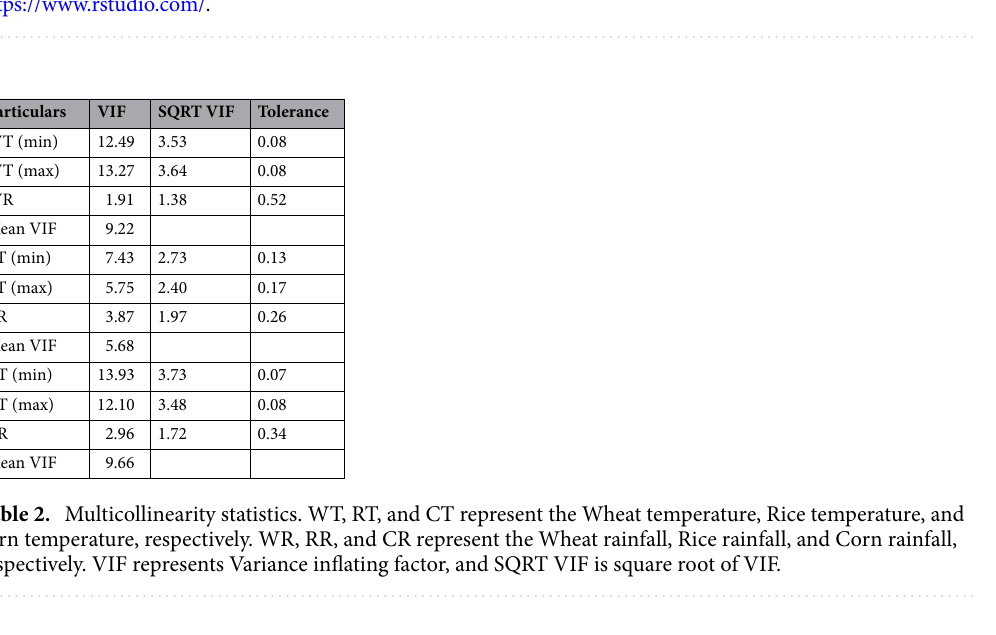
Figure 1. The map showing 11 states of SE-US considered in this study. Figure created using RStudio 2022.07.1, https:// www. rstud io. com/.